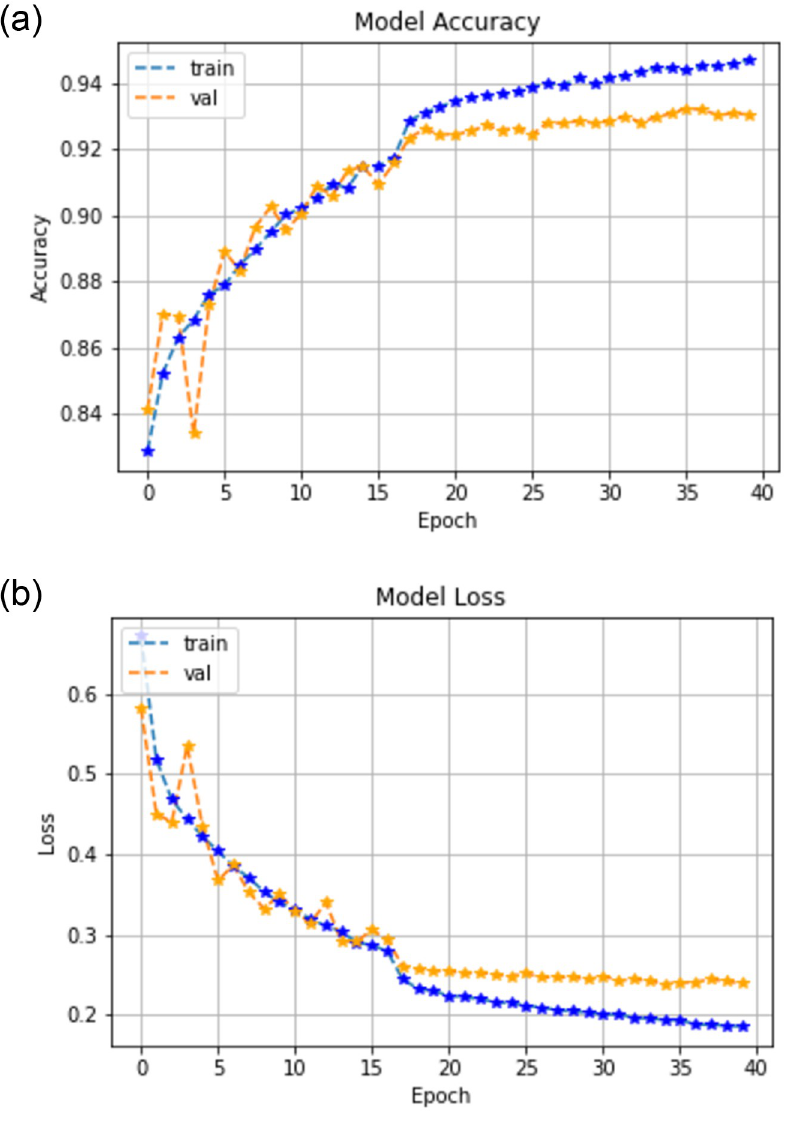
Fig 8. Model accuracy and model